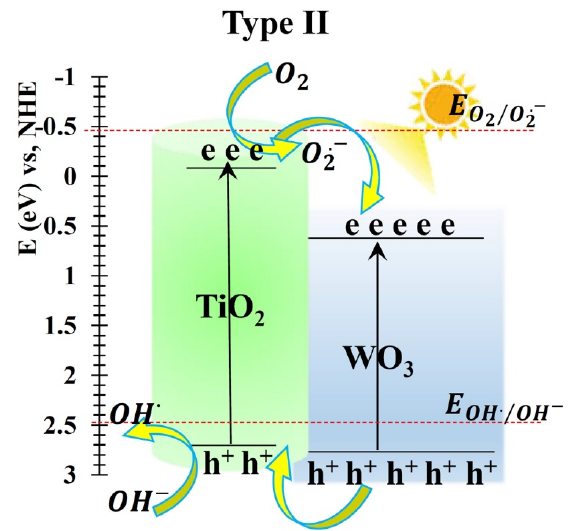
Fig. 10. Plausible type II charge transfer pathways for the photocatalytic activity of the TiO